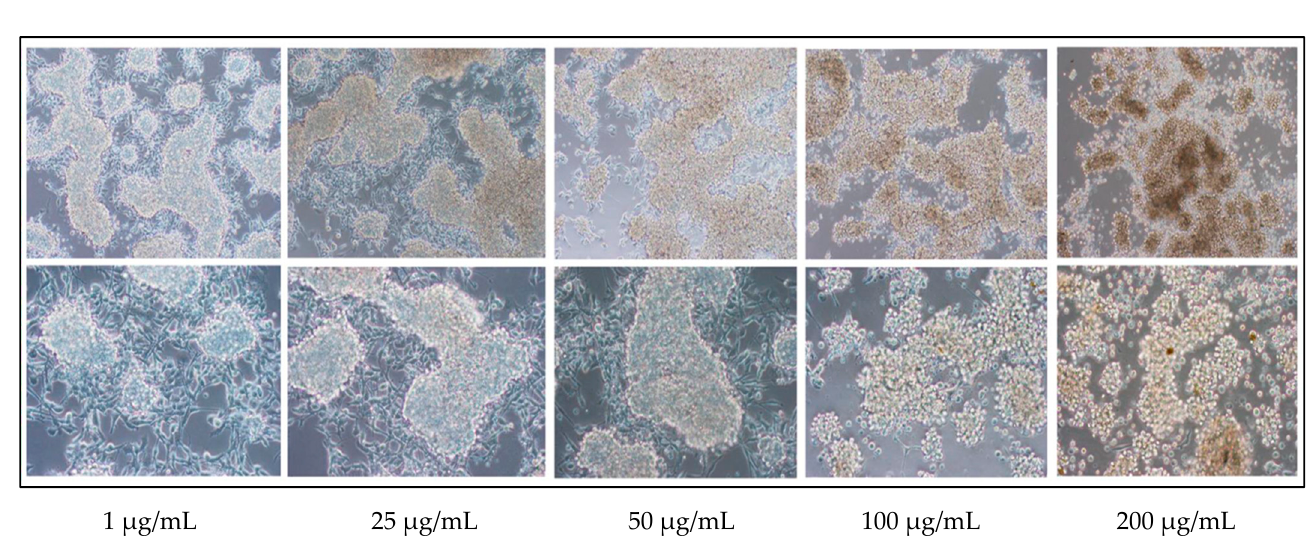
Figure 4. Cell morphology of Raji cells after treatment with 0.1% ( v / v ) dimethyl sulfoxide (DMSO), 1 mM sodium butyrate, 1 mM 12- O -tetradecanoylphorbol13-acetate (TPA) and extracts of ( A ) Ananas comosus ‘Phulae’ or ( B ) Mangifera indica ‘Namdokmai’ from 1–200 µg/mL. Upper picture magnification: 20× and lower picture magnification: 40×